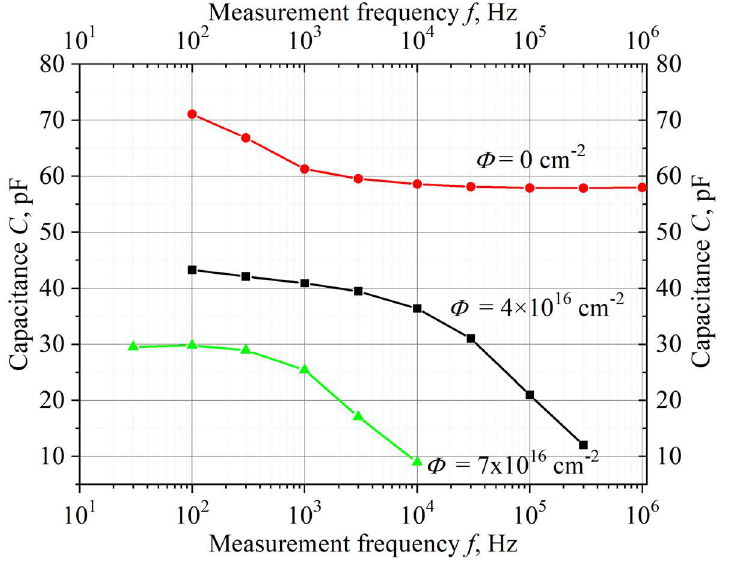
Figure 3. Frequency dependences of 4H-SiC Schottky diode capacitance at reverse bias V = −10 V for different values of fluencies Φ (irradiation with 0.9 MeV electrons).